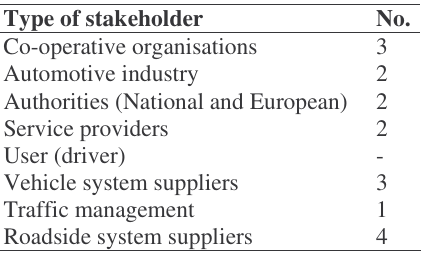
Table 1. Number of interviewees per stakeholder group Type of